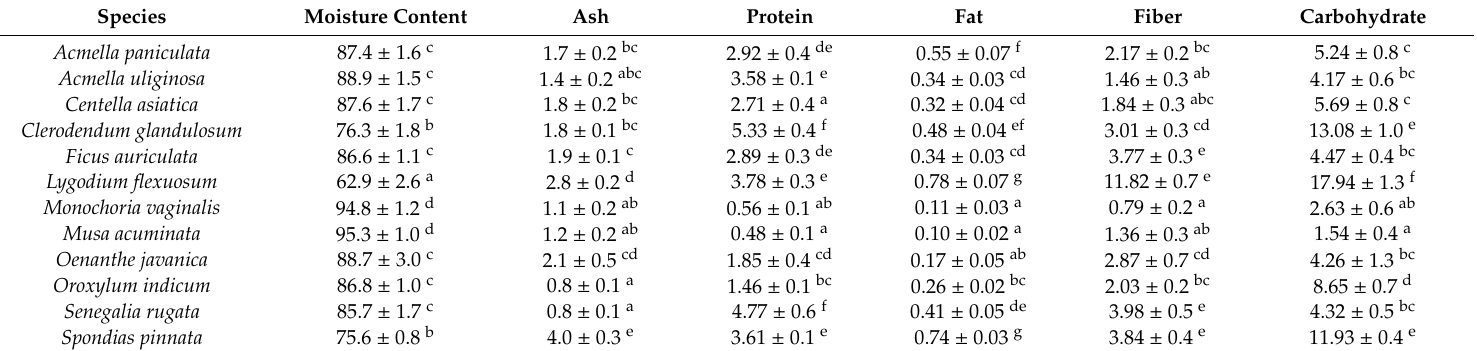
Table 2. Proximate composition of the edible parts of selected wild food plant species (g / 100 g fresh weight).